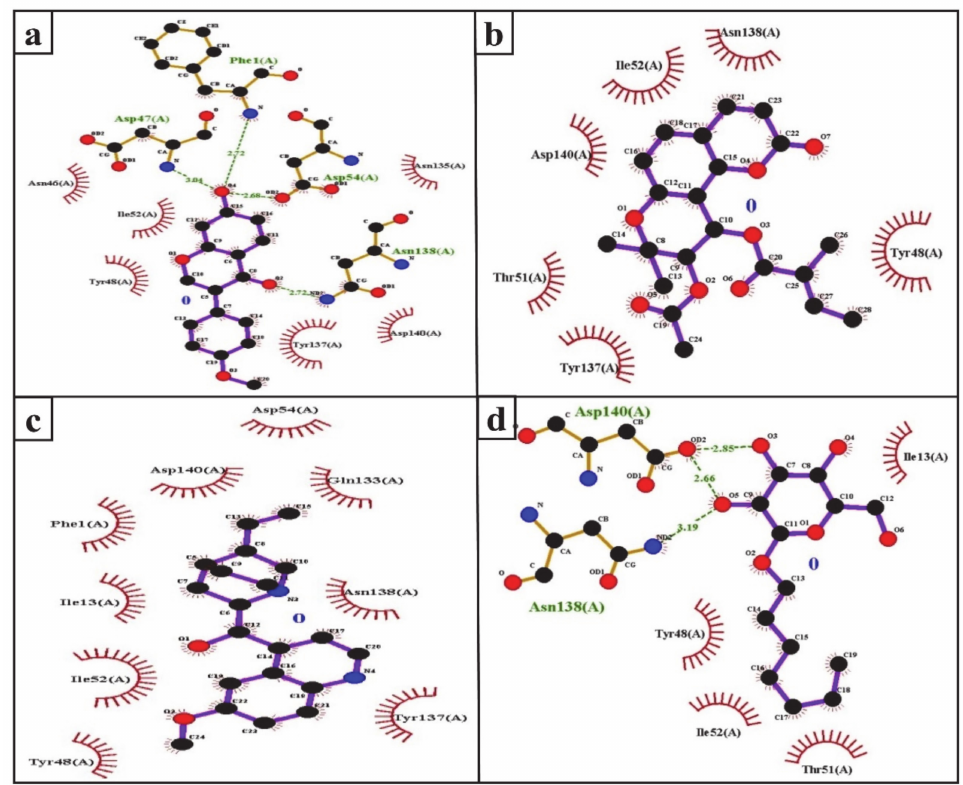
Figure 5. Ligplot analysis of the interactions of formononetin ( a ), (+)-pteryxin ( b ), quinidine ( c ), and heptyl α - D - mannopyranoside ( d ) with SGLT2. The amino acid residues forming hydrophobic interactions are shown as red arcs while the hydrogen bonds are shown as green dashed lines with indicated bond